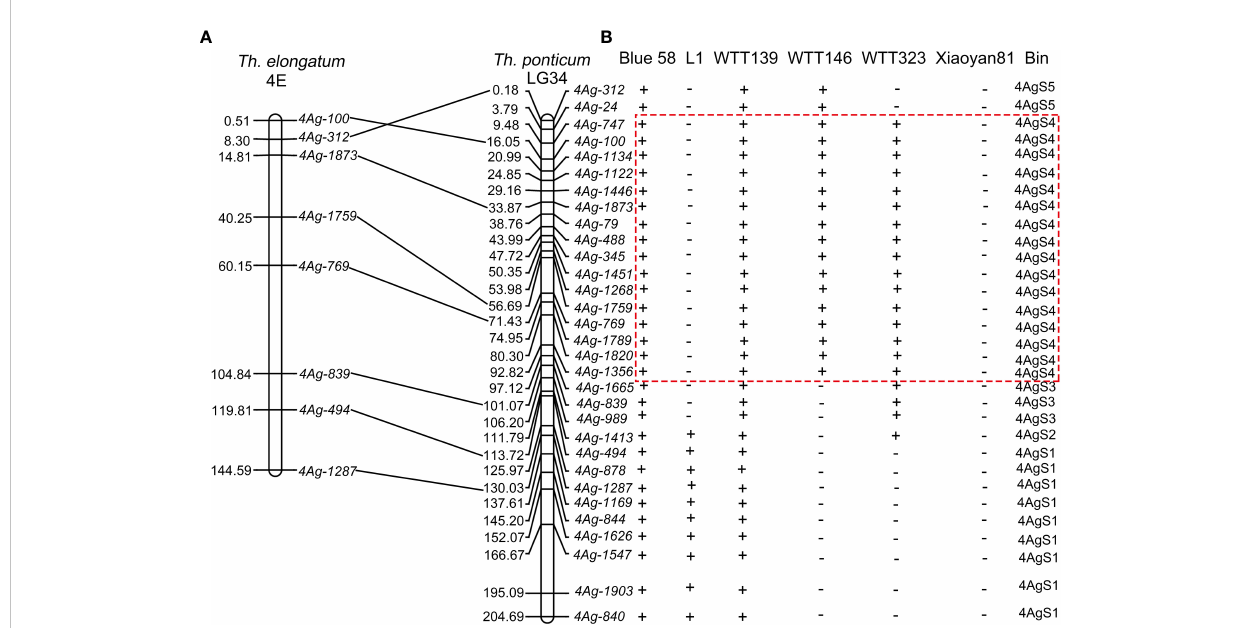
FIGURE 7 Synteny analysis and PCR ampli fi cation. (A) Synteny relationship of speci fi c marker ampli fi cation products between Th. elongatum chromosome 4E and Th. ponticum chromosome LG34. (B) Ampli fi ed results in Blue 58, four translocation lines and Xiaoyan 81. The symbols ‘ + ’ and ‘ − ’ indicate the presence and absence of the speci fi c marker loci, respectively. The dotted box indicates the physical region of Pm